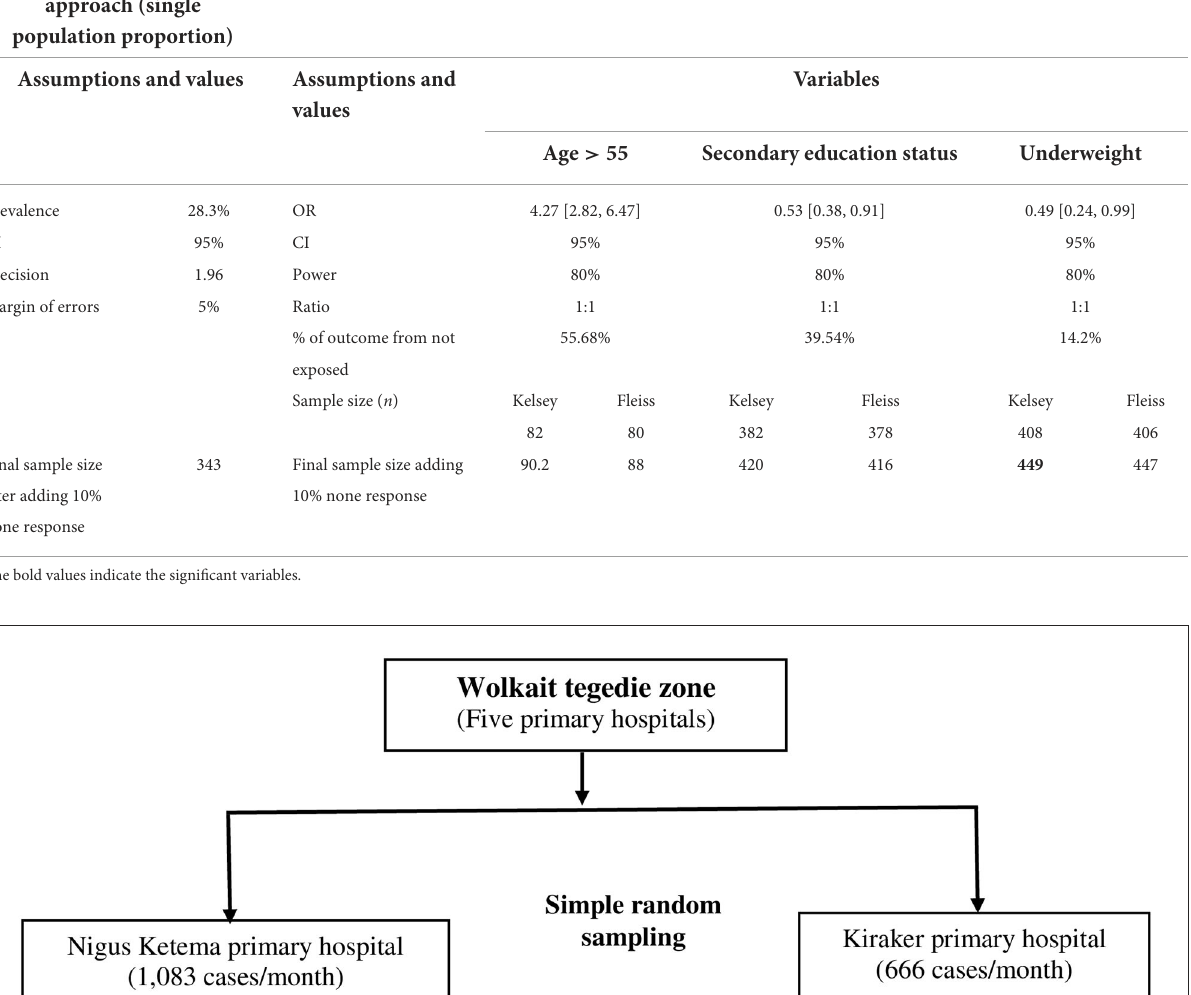
TABLE 1 Sample size calculation based on the two objectives.